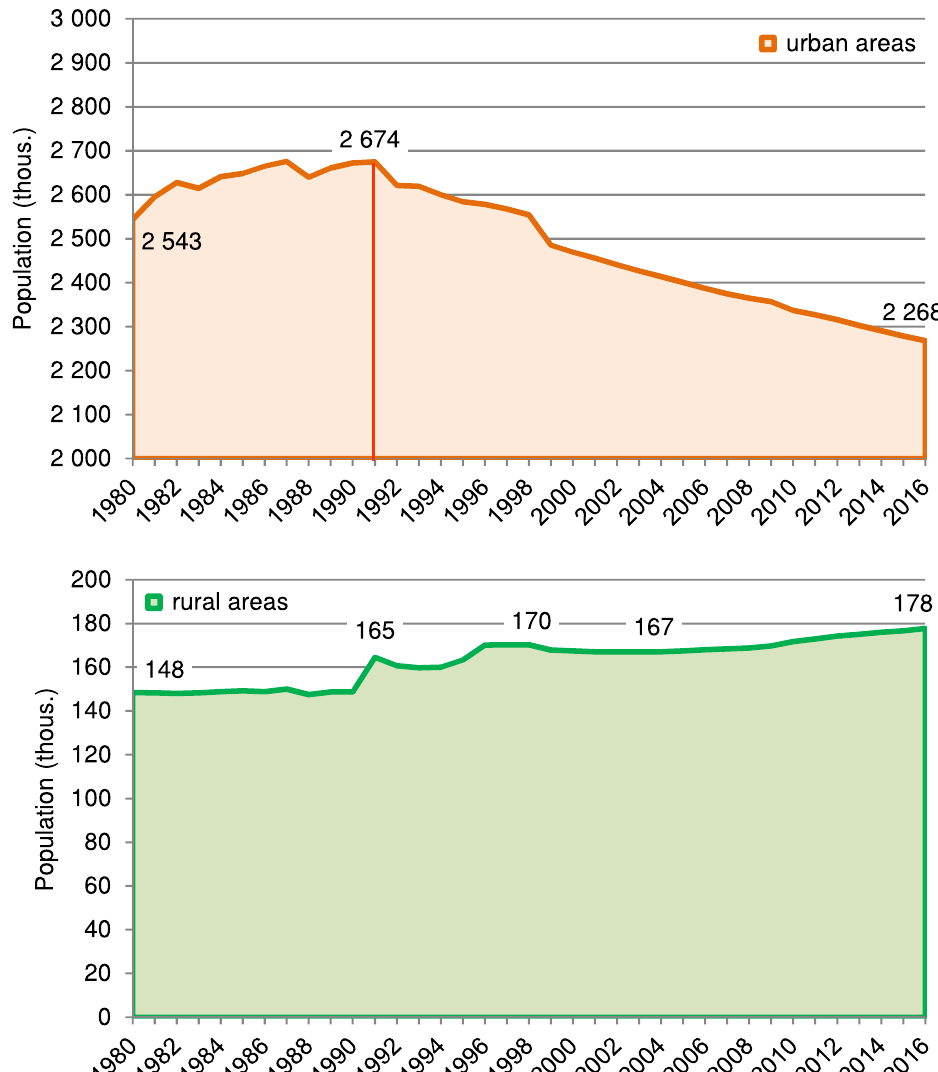
Fig. 3. Changes in the population of urban and rural areas of the Katowice conurbation, 1980–2016 (Source: own elaboration based on Local Data Bank of the Central Statistical Office; Rocznik Statystyczny Województwa Katowickiego 1981,–1995, WUS, Katowice)